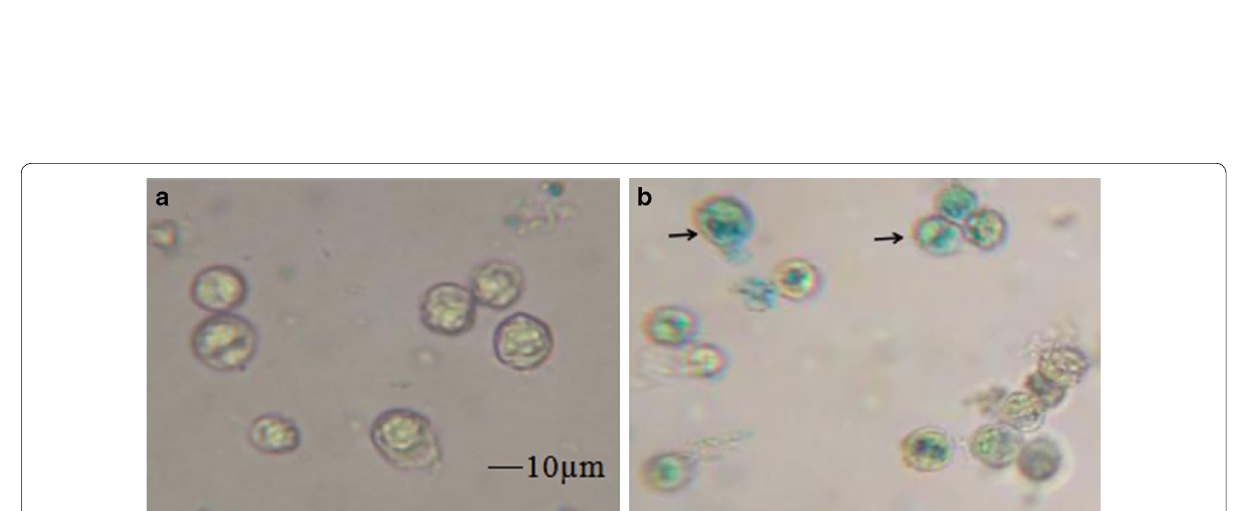
Fig. 4 a Negative control: D. salina cells were transformed with the plasmids pCAMBIA1303-N; b transformed group: D. salina cells were transformed with the plasmids pCAMBIA1303. Arrow represented the positive transformants with the blue